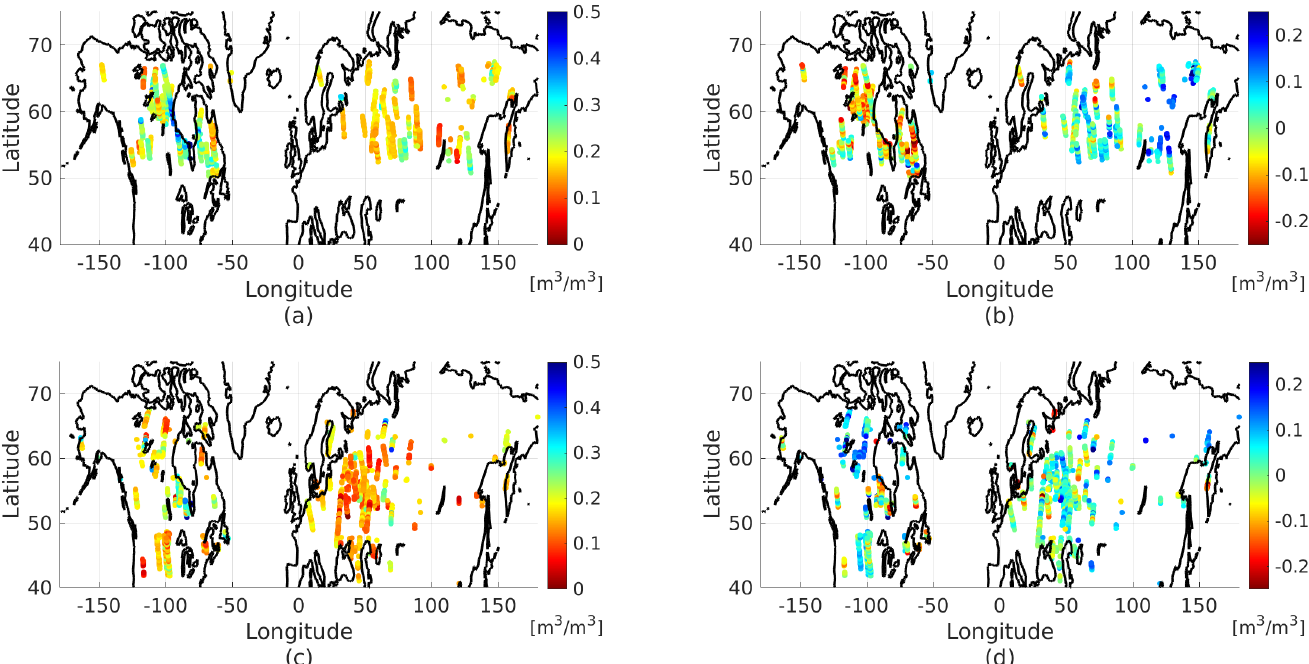
Figure 10. ( a , c ) GNSS-R-derived SM estimations corresponding to N = 20. ( b – d ) Error with respect to the collocated SMOS SM product. The map presents the measurements collected by FMPL-2 from ( a , b ) 1–31 October 2020 and from 1 November to 4 December 2020. Only reflections collocated with SMOS SM data are